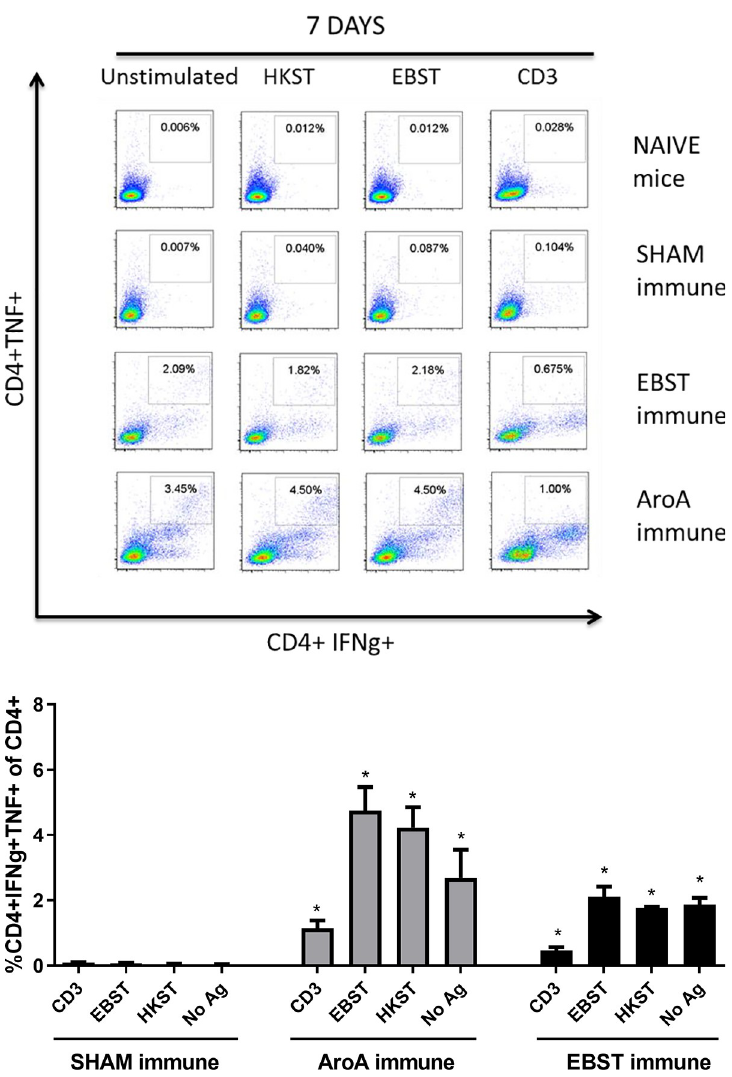
Fig 11. EBST immune mice exhibit Salmonella specific multifunctional CD4+ T cells during virulent Salmonella challenge. Simultaneous production of cytokine IFN γ and TNF by antigen specific CD4+ T cells was measured using multiparameter flow cytometry and intracellular cytokine staining (ICS) of splenocytes for individual EBST immune, AroA immune and Sham immune mice at 7 days post infection with virulent ST (Fig 11A). For comparison, na ï ve mice splenocytes were included. Antigens used were EBST and HKST (2 x10 7 cells/well) and anti-CD3 antibody as positive control. Unstimulated splenocytes were included as control. The percentages in the gated region of dot plots indicate the proportion of CD4 + IFN γ + TNF + of total CD4+ splenocytes. Data are representative of three individual mice per group. The bar graphs represent mean ± SEM of 3 mice per group. Y axis represents percentage of CD4 + IFN γ + TNF + of total CD4+ splenocytes (Fig